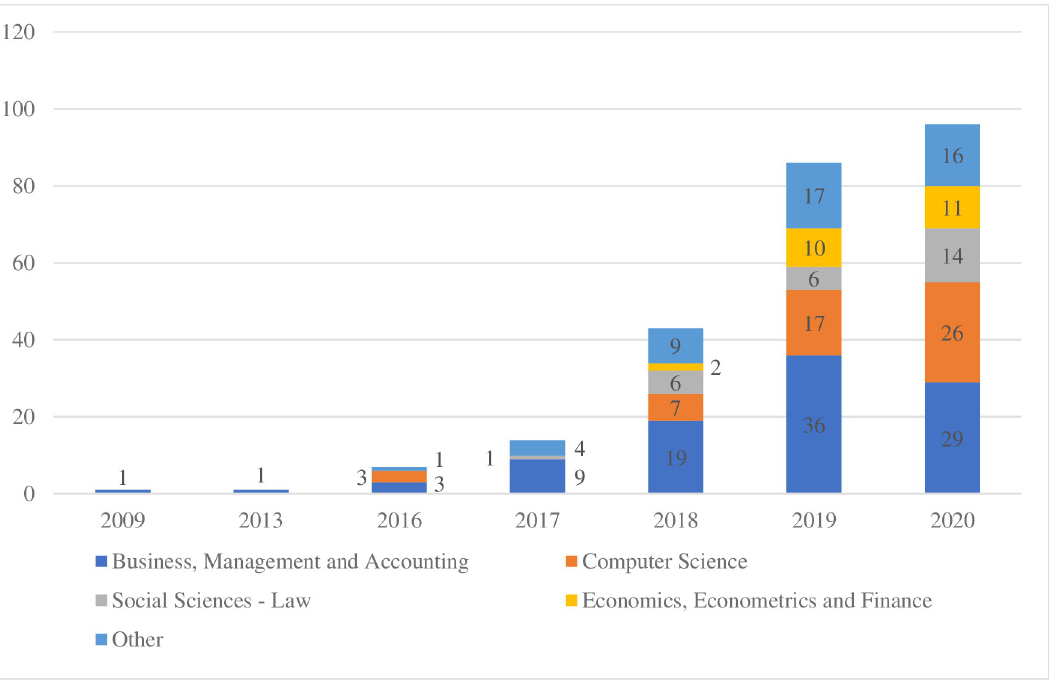
Fig 5. Final dataset documents by category